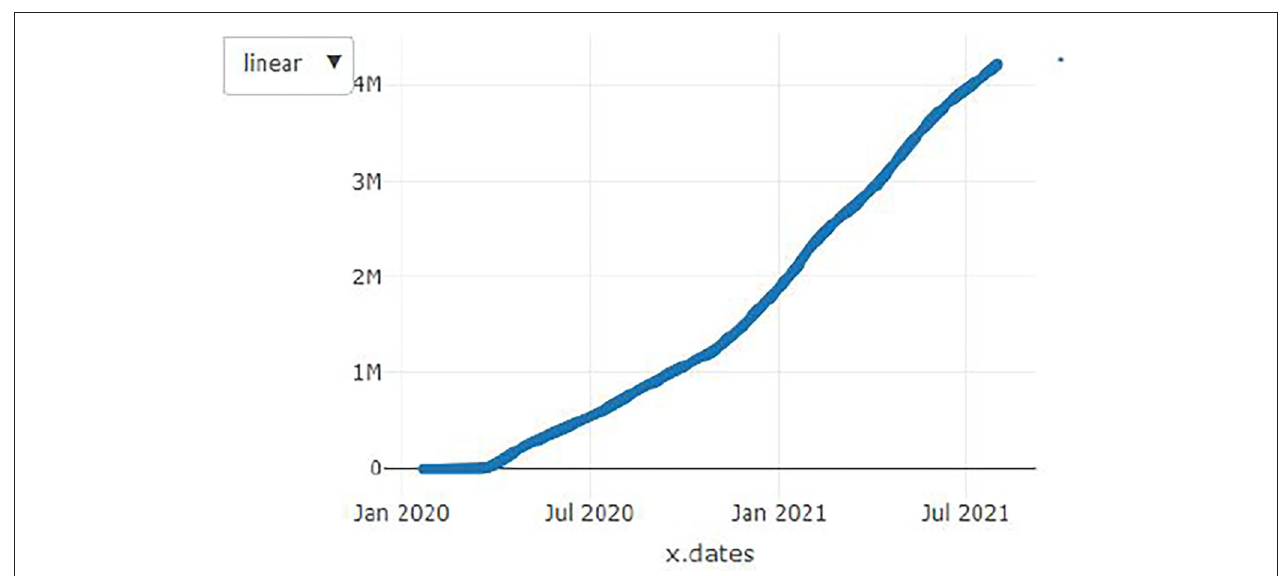
FIGURE 10 | Global